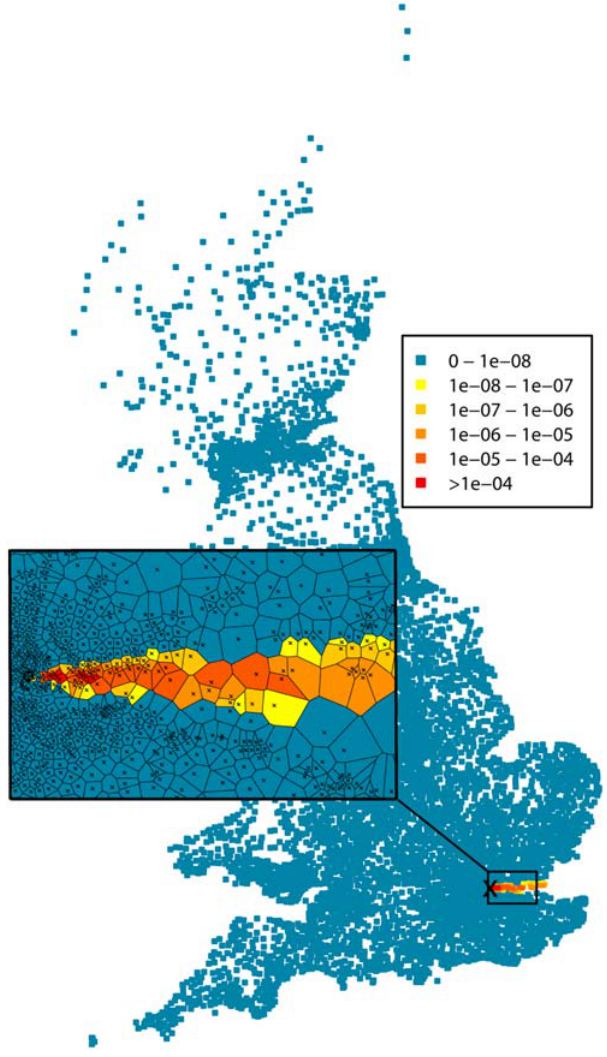
Figure 1. Map of the risk of anthrax infection (attack rates) in each ward for all scenarios except scenario D. The cross on the main map represents the location of all simulated releases. The inset map represents population-weighted ward centroids (crosses) and their Voronoi diagram (polygons).